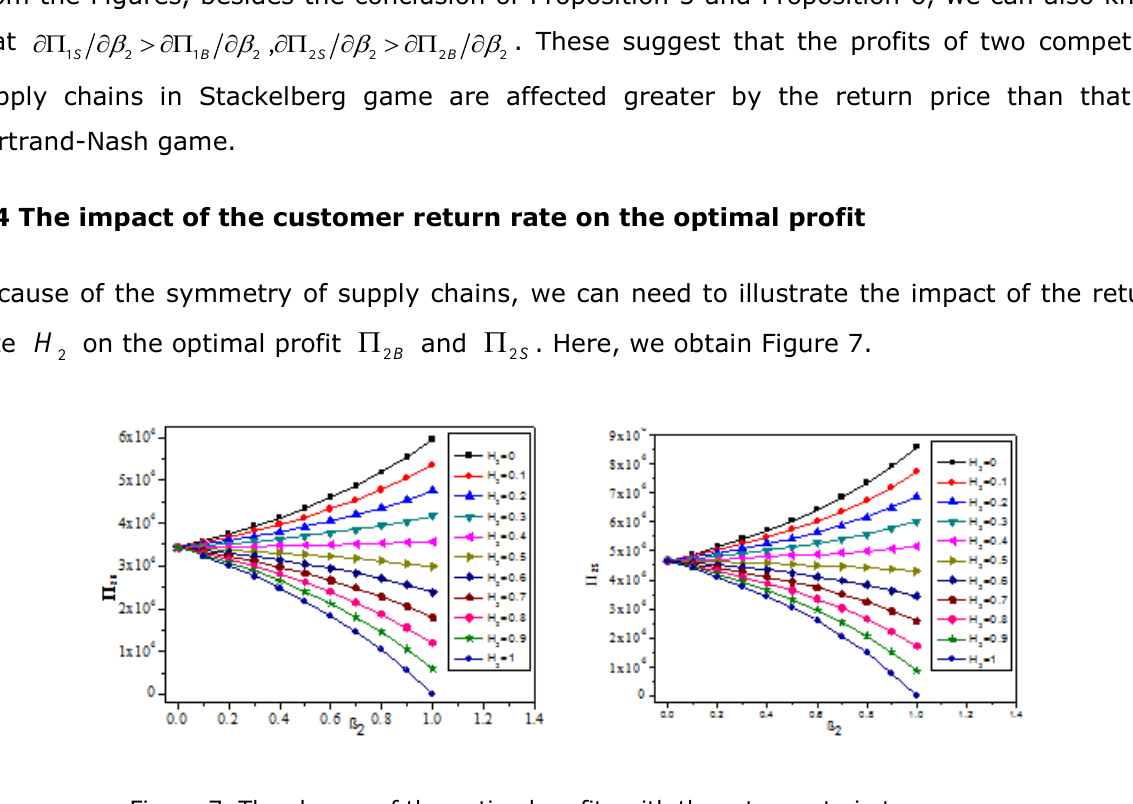
Figure 7. The change of the optimal profits with the return rate in two